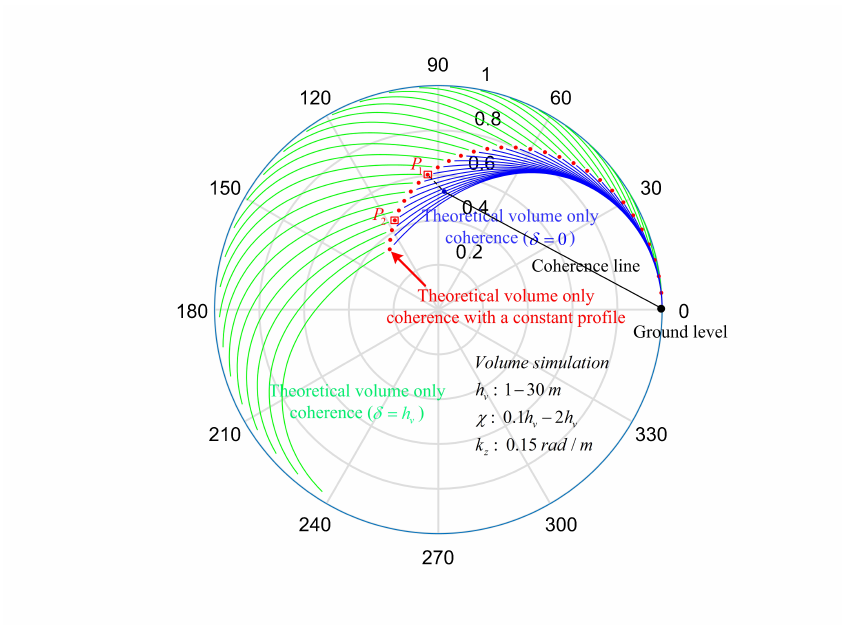
Figure 5. The solution space of two-dimensional Gaussian vertical backscatter model. Each blue or green curve, or red dot represents the volume only coherence for a given forest height at an interval of 1 m. The terrain slope is set to 0. The blue dot refers to the solution volume only coherence, and the minimum distance between it and the δ = h v solution space is indicated by the black dotted line. P 1 is the final solution in δ = h v solution space, while P 2 corresponds to the solution forest height in δ = 0 solution space. Both P 1 and P 1 lie on the solution space curve of the constant